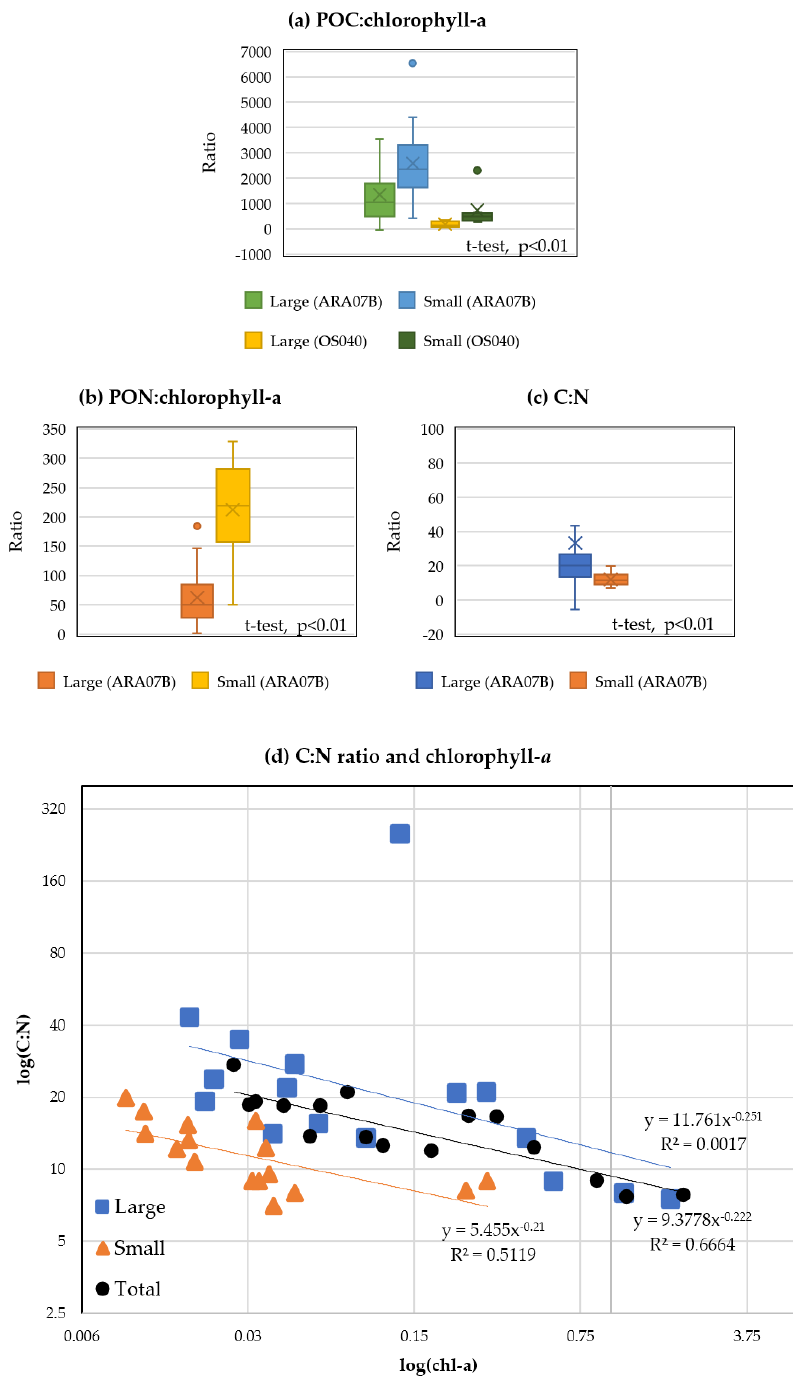
Figure 11. Comparison of ( a ) POC:chlorophyll- a ratios, ( b ) PON:chlorophyll- a ratios and ( c ) C:N ratios between small and large phytoplankton in the northern Bering and Chukchi seas. Only POC:chlorophyll- a data available for the OS040. ( d ) C:N ratio and chlorophyll-a of each size